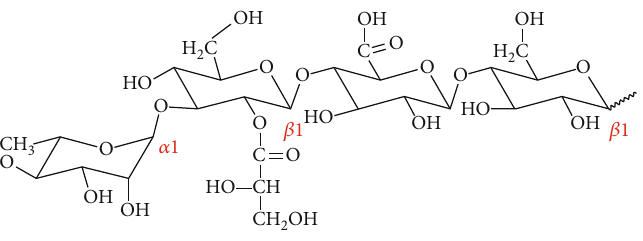
Figure 4: The structure of gellan gum.